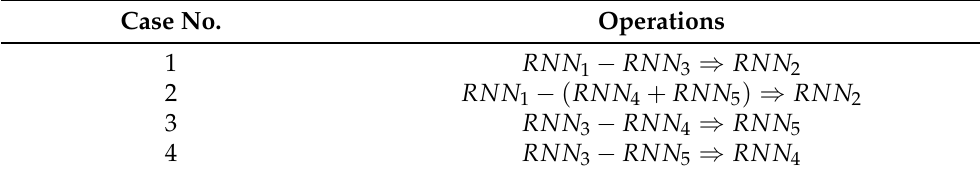
Figure 4. The considered configurations of data determined by RNN: ( a ) sum of all phases, ( b ) sum of ferrite and pearlite, ( c ) sum of bainite and martensite, ( d ) bainite, and ( e ) martensite. Table 1. Analyzed configurations of the considered examples.